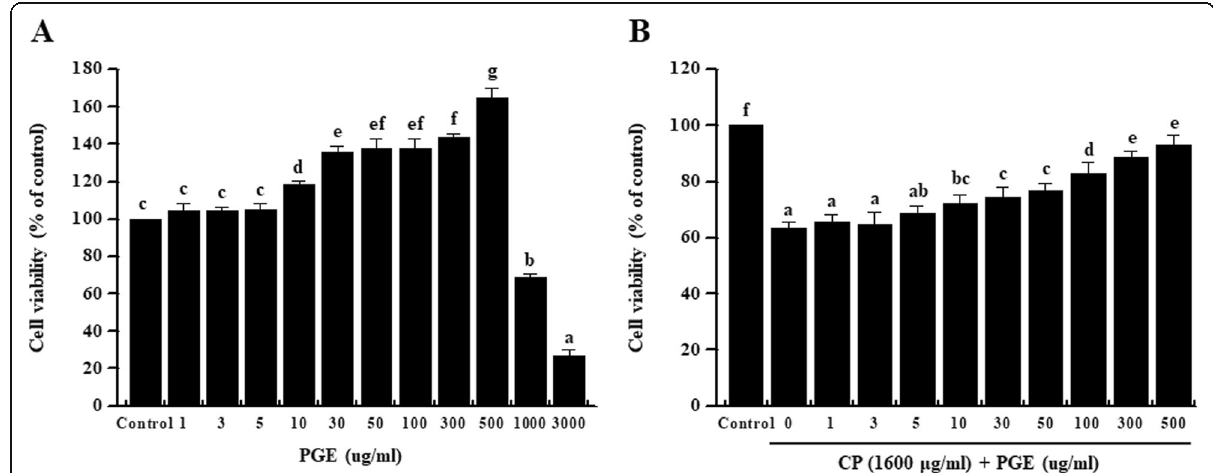
Fig. 2 Effect of PGE on cytotoxicity of splenocytes and cell viability of CP-treated splenocytes. a Splenocytes were seeded into a 96-well plate with PGE (0, 1, 3, 5, 10, 30, 50, 100, 300, 500, 1000, and 3000 μ g/mL). b Splenocytes were treated with PGE (0, 1, 3, 5, 10, 30, 50, 100, 300, and 500 μ g/mL) and/or CP (1600 μ g/mL). Cells were incubated for 24 h in under 5% CO 2 , and their viability was measured using a WST-1 Assay Kit. Bars labeled with different superscripts indicate significant differences ( P < 0.05). Data are presented as the means ± standard errors ( n =